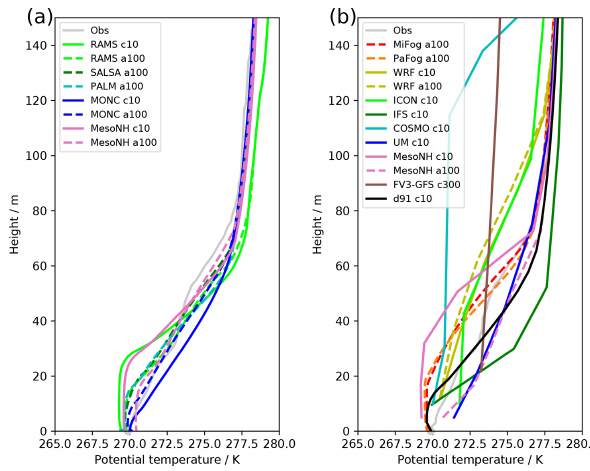
Figure 6. Potential temperature observed and simulated by (a) the low aerosol/CDNC LES models and (b) the low aerosol/CDNC SCMs at 00:00UTC.